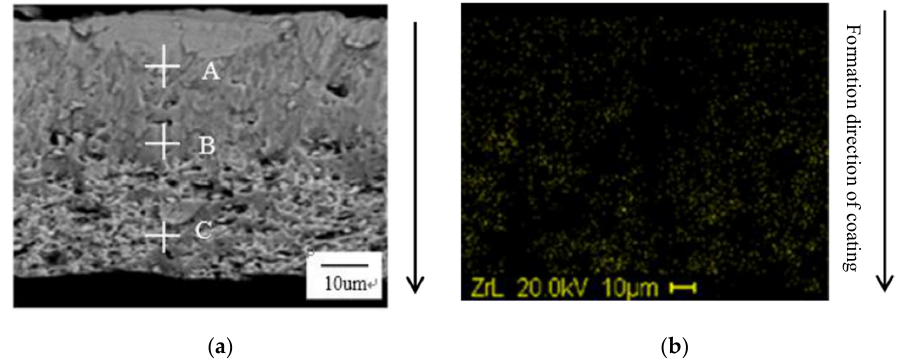
Figure 3. SEM image and element distribution mapping of cross-sectional Ni/ZrO 2 gradient coating. ( a ) Cross-section morphology; ( b ) Zr element distribution diagram.